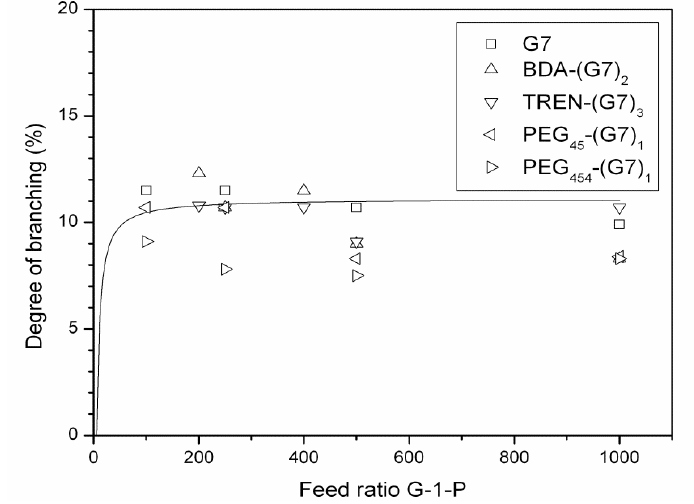
Figure 8. Degree of branching as a function of the feed ratio